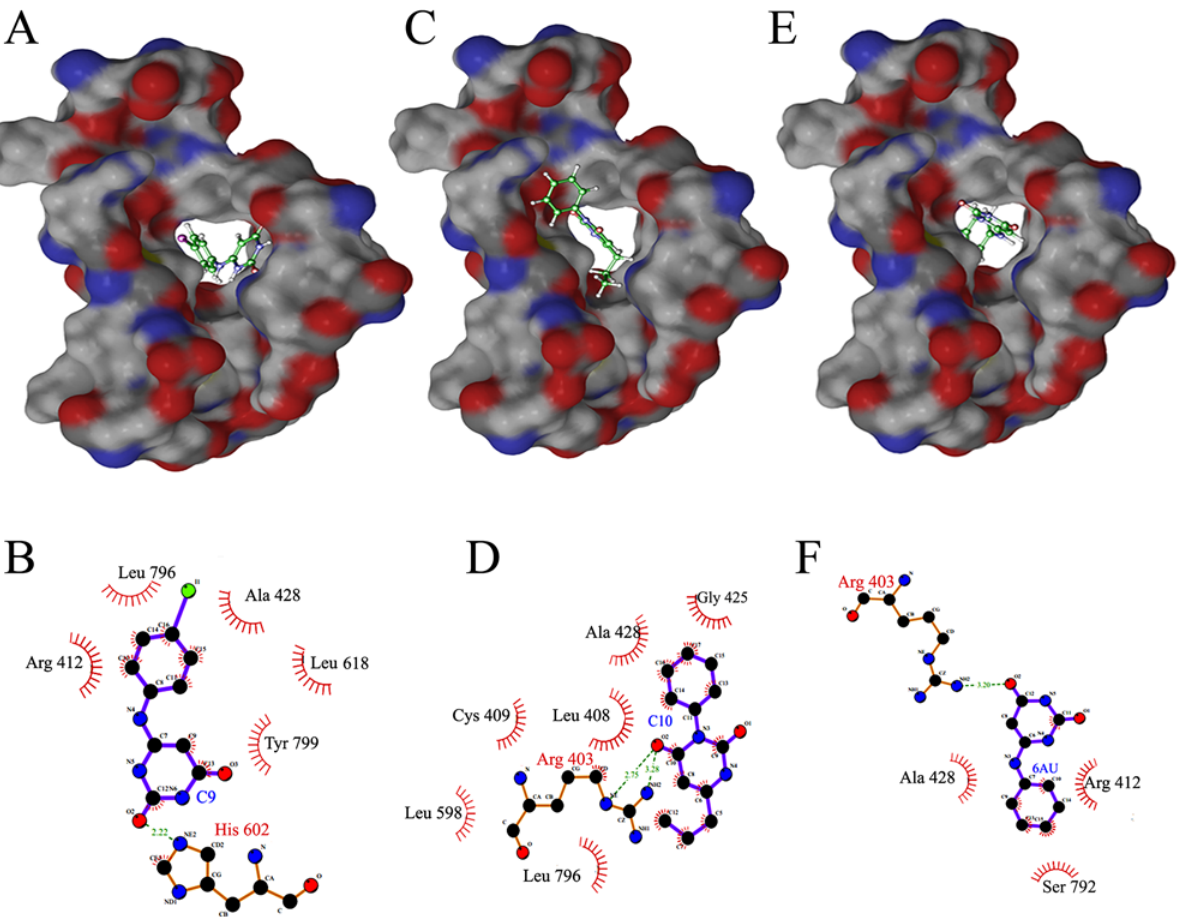
Fig 5. Docked Complex of Mtb DnaE2 with 6-AU and its Analogues. Panels A, C, and E show the electrostatic surface potential of modeled Mtb DnaE2 with bound ligands (stick models, shown in atom colors). (A) 6-(4-iodoanilino)-1H-pyrimidine-2,4-dione (C9), (C) 3-phenyl-6-propyl-1H-pyrimidine-2,4-dione (C10), (E) 6-anilino-1H- pyrimidine-2,4-dione (control). Panels B , D, and F show 2D representations of ligand C9, C10, and 6-AU with interacting amino acid residues of Mtb DnaE2 respectively. Green dashed lines indicate hydrogen bonds, with the numbers indicating the interatomic distances ( Å ). The labeled arcs with radial spokes that point toward the ligand atoms show the hydrophobic interactions with the corresponding amino acid